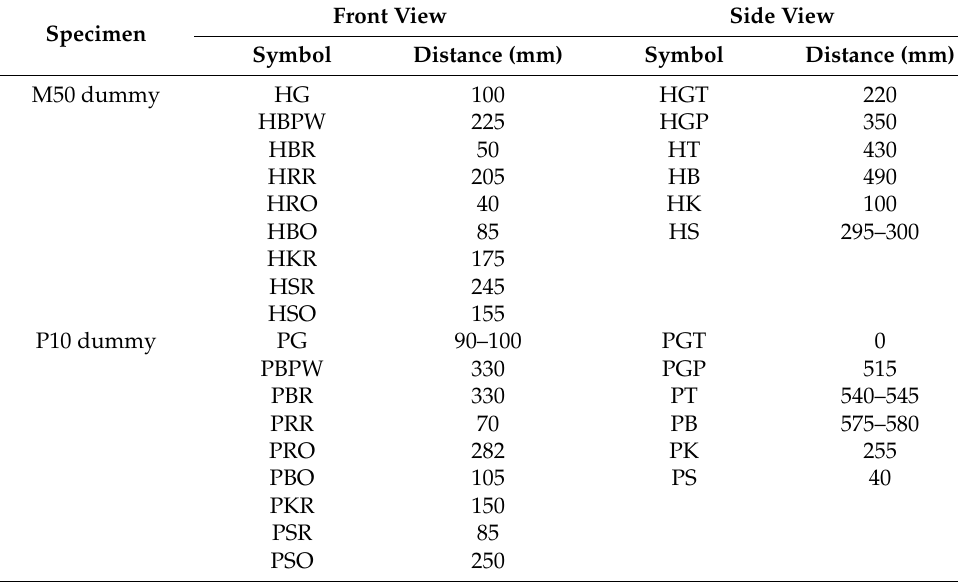
Table 1. Distances describing the position of the